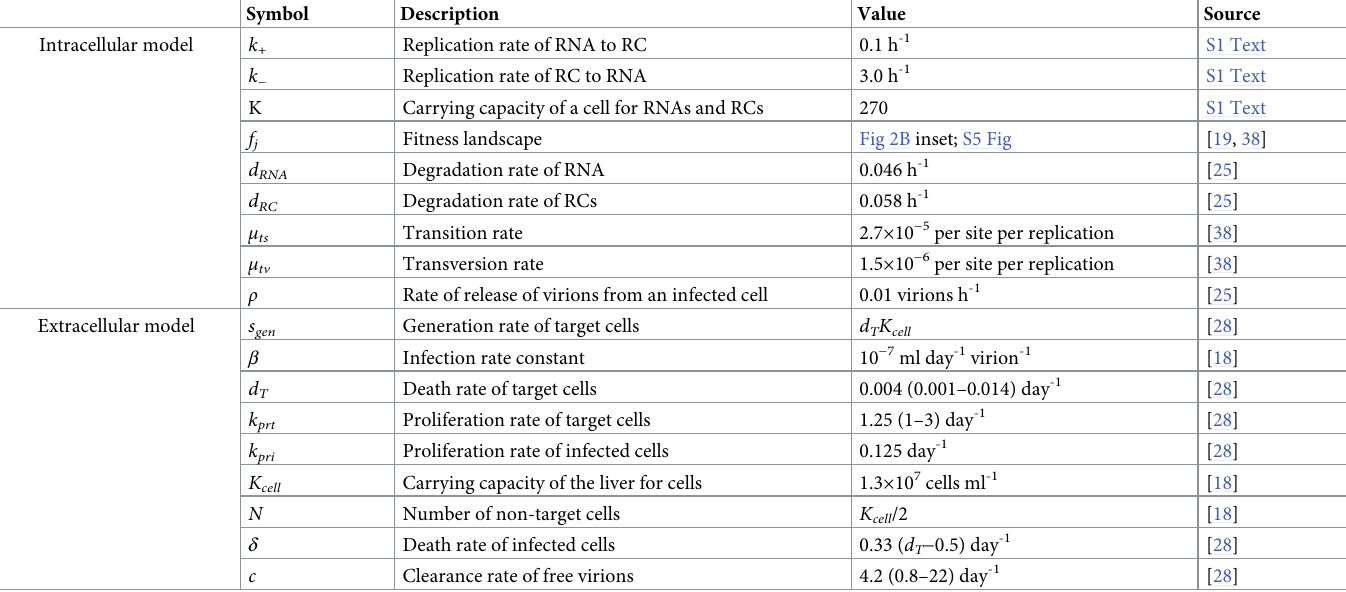
Table 1. Model parameters and their values.